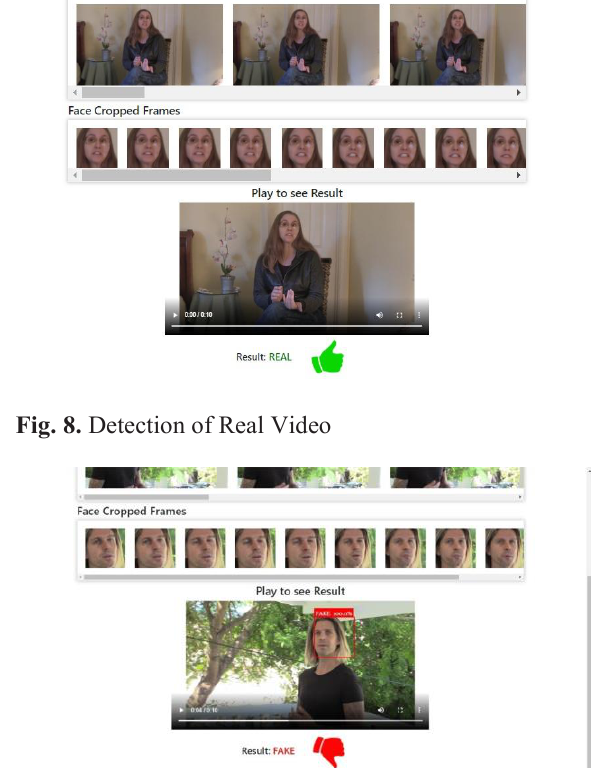
Fig. 9. Detection of Fake video along with confidence